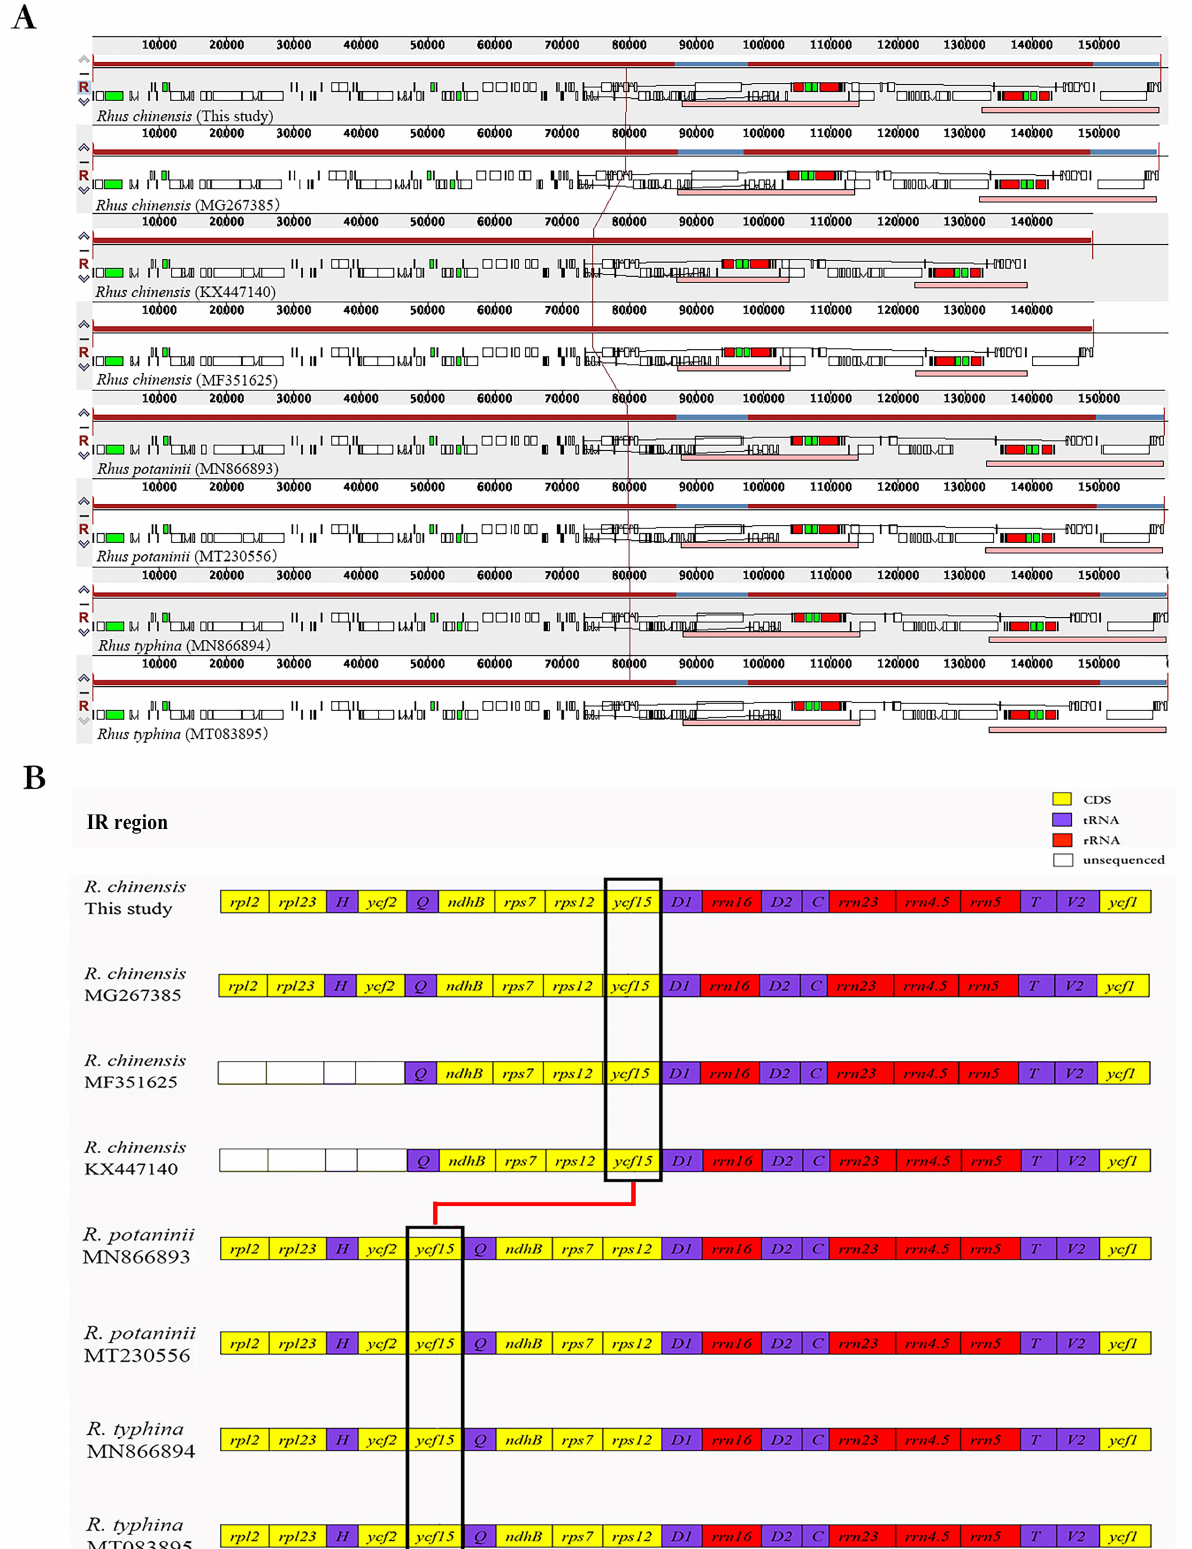
Figure 4. Gene arrangement of eight chloroplast genomes of Rhus species. ( A ) Complete genomes. ( B ) IR regions. The gene ycf15 in the black frame changed position (rearranged) in the chloroplast genome of Rhus